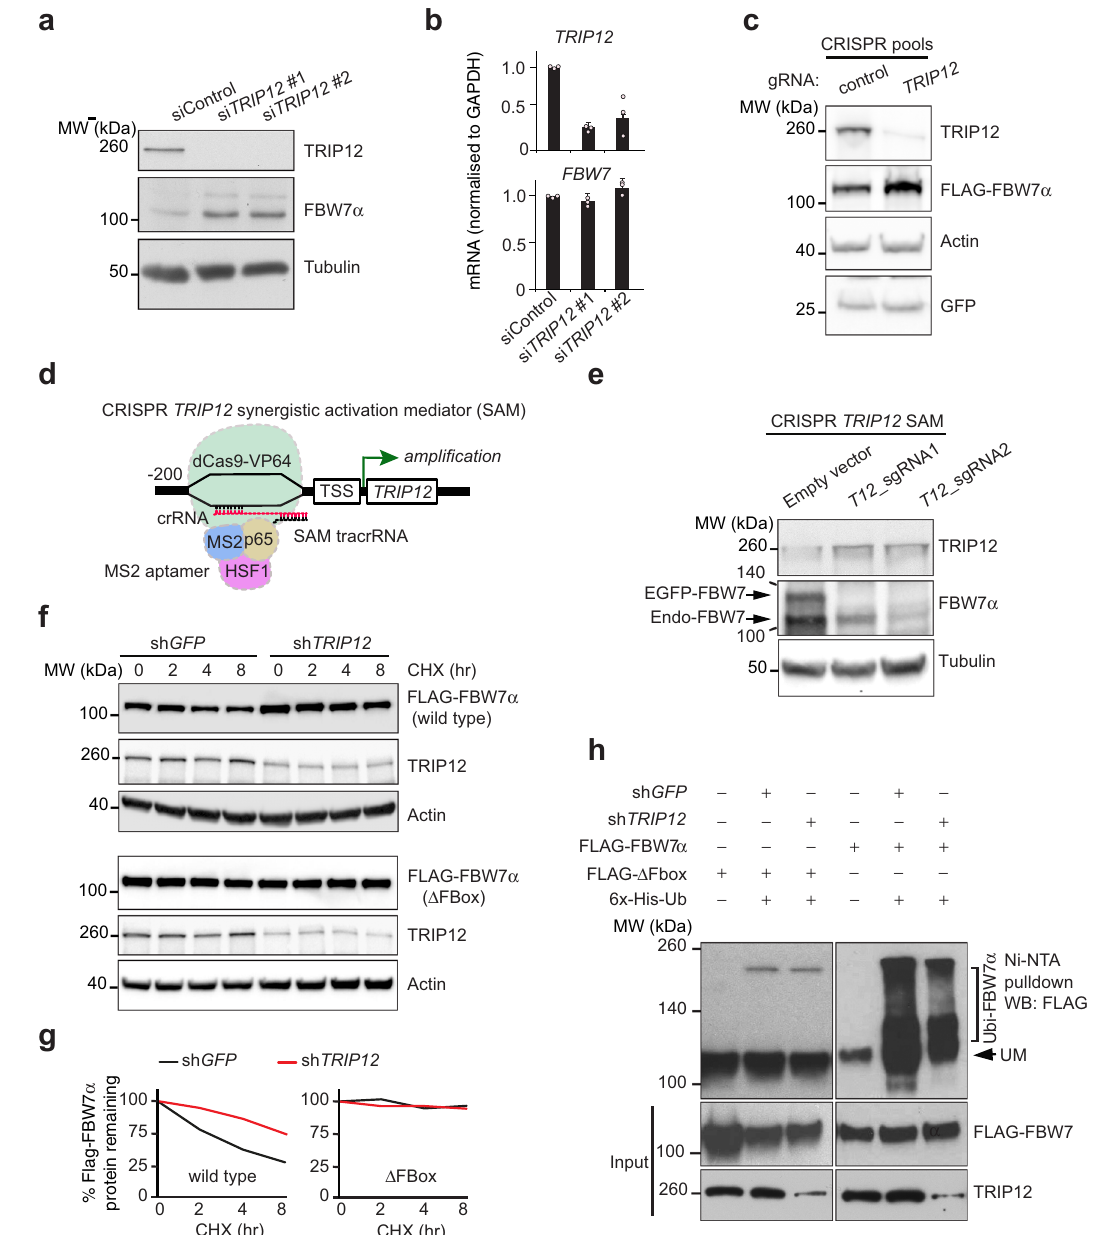
Fig. 2 TRIP12 negatively regulates FBW7 protein stability. a Western blot validation of TRIP12 as a negative regulator of endogenous FBW7 on lysates from cells transfected with two independent siRNAs targeting TRIP12 gene compared to a non-targeting control. b qRT-PCR analysis of TRIP12 and FBW7 , n = 3 independent experiments. Bar graphs represent the mean ± SD of three independent experiments. c Western blots for the indicated proteins showing stabilisation of FBW7 in CRISPR/Cas9 HCT116 pools targeting TRIP12 compared to wildtype parental cells. GFP plasmid was used as transfection control and subsequently GFP and Actin blots were used as loading controls. d Schematic of CRISPR/Cas9 SAM sgRNAs targeting endogenous TRIP12 locus. e Western blot validation of TRIP12 SAM activation and negative regulation of FBW7 in HEK293T cells expressing EGFP-FBW7 α . f Protein stability of epitope-tagged FBW7 in stable cell lines expressing a lentivirus-mediated GFP-targeting control (sh GFP ) versus sh TRIP12 ; quanti fi cation of FBW7 protein levels normalised to actin from two independent experiments is shown in g . h Ni-NTA pulldown of Δ Fbox-mutant and ubiquitylated wildtype FBW7 in stable HEK293T cells expressing the indicated shRNAs. Western blots in all panels are representative of at least three independent experiments unless otherwise stated. Source data are provided as a Source Data fi